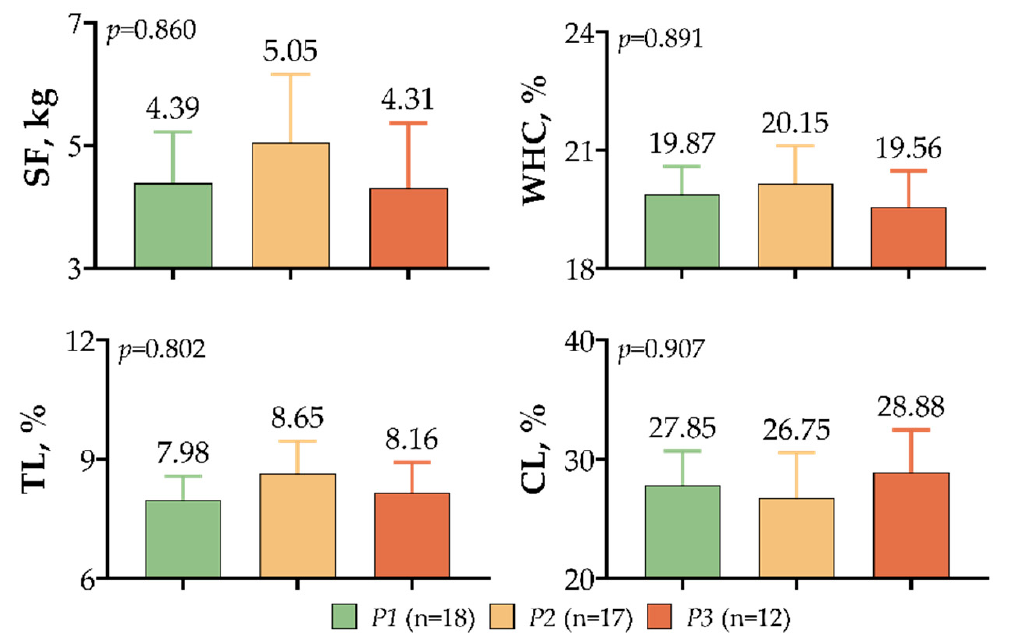
Figure 7. Effect of GHE5 polymorphism on meat quality assessment SF: Shear force; WHC: Water holding capacity; TL: Thawing loss; CL: Cooking loss.